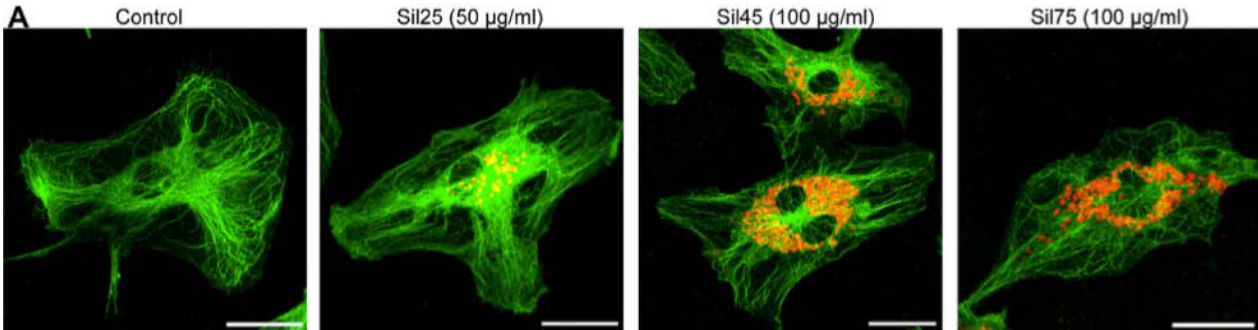
Fig. 8. E®ect of silica particles on cell morphology. (a) Representative confocal images of control HUVEC cells (left) or HUVEC cellsexposedfor24htoSil25(25nm),Sil45(45nm)orSil75(75nm)atnoncytotoxicconcentrations,being50 (cid:1) gmL-1,100 (cid:1) gmL-1and 100 (cid:1) g mL-1, respectively. The images shown are merged images of both the SNP (red) and the a-tubulin cytoskeleton (green). Reprinted with permission from Ref. 122. Copyright ° c 2013 Acta Materialia Inc. with permission from